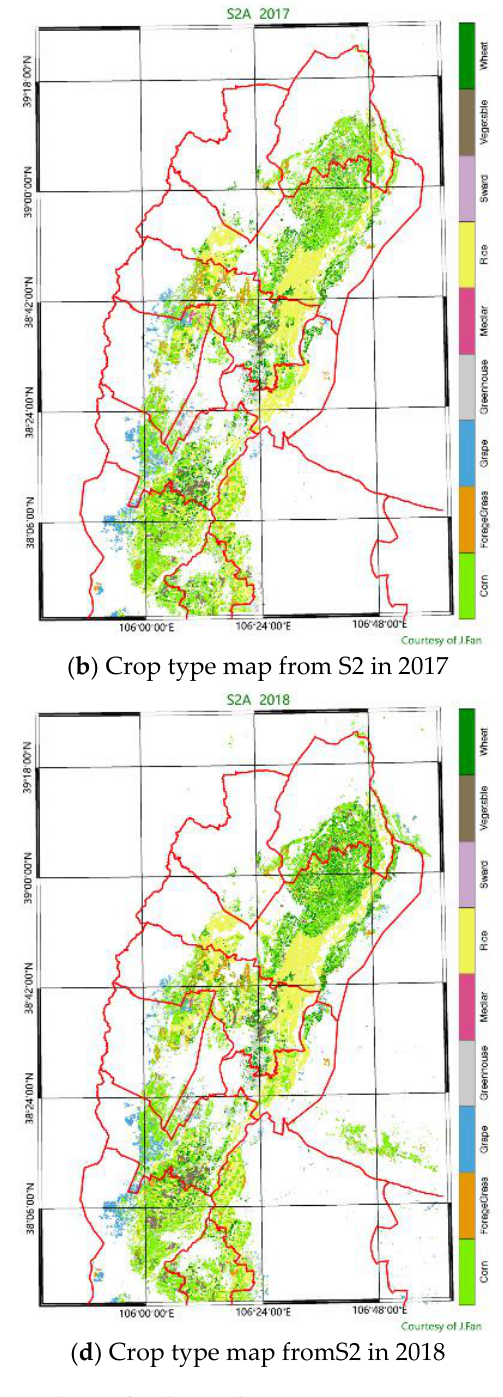
Figure 5. The best crop type map from S-2 and GF-1 for this study. Table 7. The accuracy of the classified results from GF-1 and S-2 for the two years.